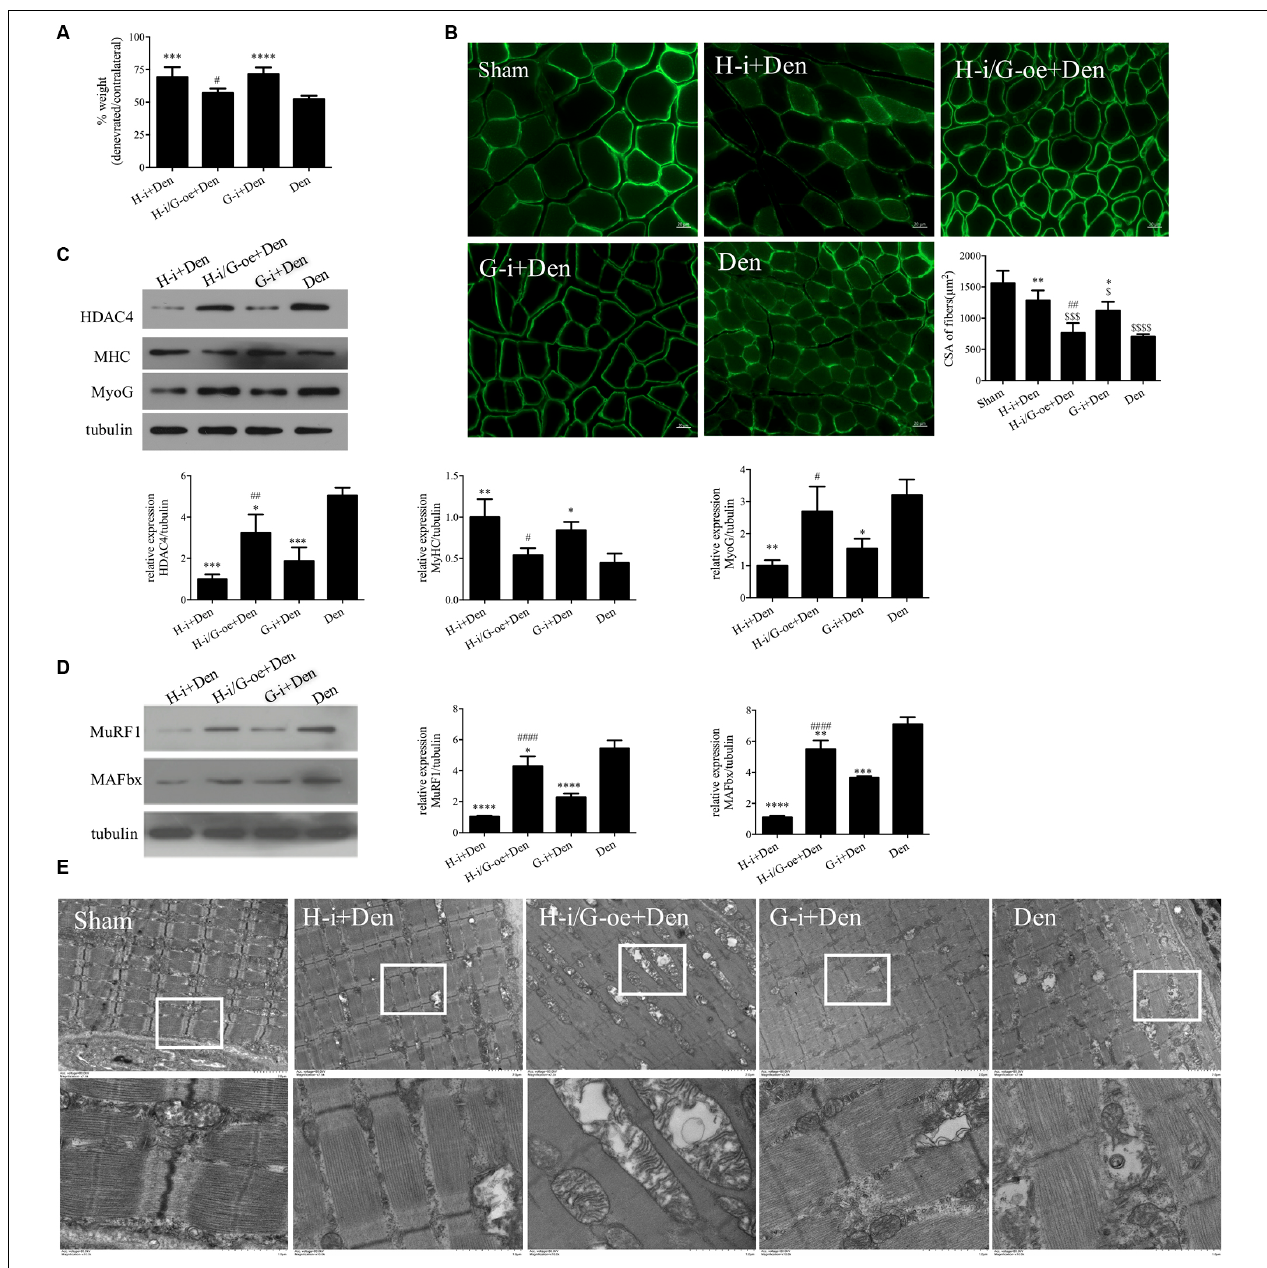
FIGURE 5 | HDAC4 inhibition alleviated denervation-induced muscle atrophy by downregulating myogenin (MYOG). (A) The sciatic nerve transection model was prepared after injection of HDAC4-shRNA lentivirus (H-i+Den), HDAC4-shRNA+MYOG overexpression lentivirus (H-i/G-oe+Den), MYOG-shRNA lentivirus (G-i+Den) or empty vector virus (Den) into the tibialis anterior muscle of mice 3 days, and muscle weight ratio was measured after denervation for 14 days. (B) Laminin staining was used to analyze the cross-sectional area of muscle fibers. (C,D) Protein levels of HDAC4, MYOG, MyHC, MAFbx and MuRF1 in muscle were detected by Western blot. (E) Observation of mitochondrial cavitation degeneration and mitophagy in muscle fibers by Transmission Electron Microscopy (TEM). ∗ P < 0.05, ∗∗ P < 0.01, ∗∗∗ P < 0.001, ∗∗∗∗ P < 0.0001 vs. denervated group. # P < 0.05, ## P < 0.01, #### P < 0.0001 vs. HDAC4-shRNA lentivirus group. $ P <